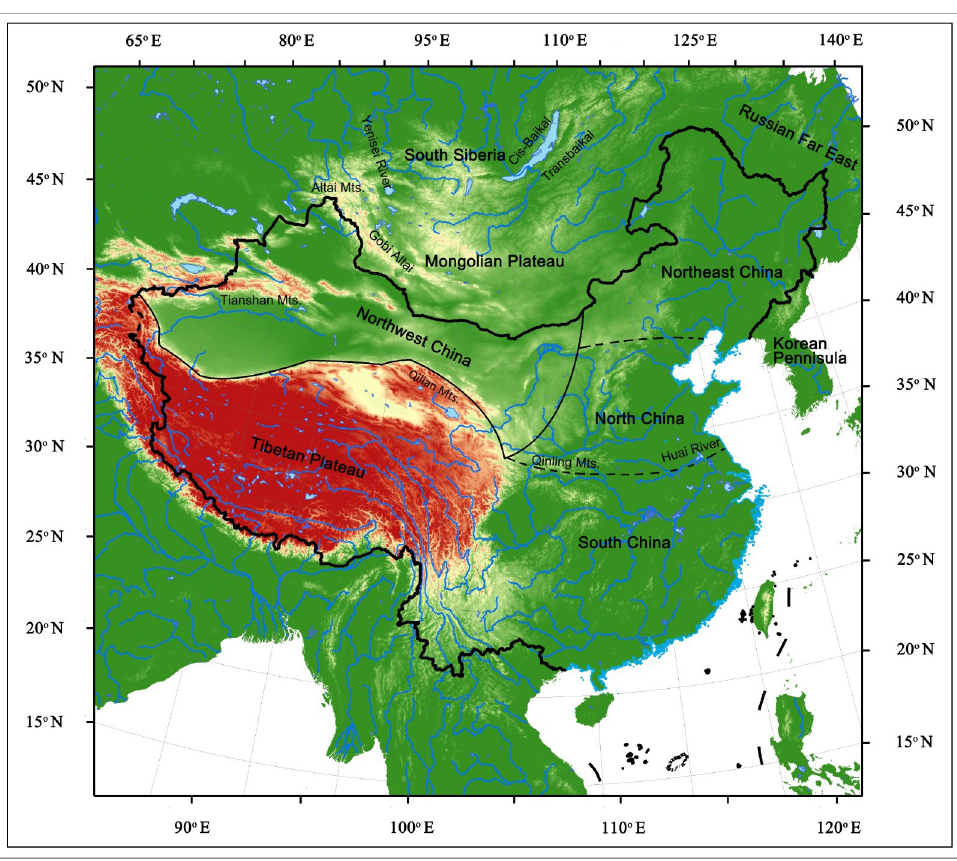
Fig 1. Map showing the location and topographic features of the subdivisions of northern China (Northeast China, Northwest China and North China) and its surroundings. The base map raster is made from the USGS digital elevation map data from